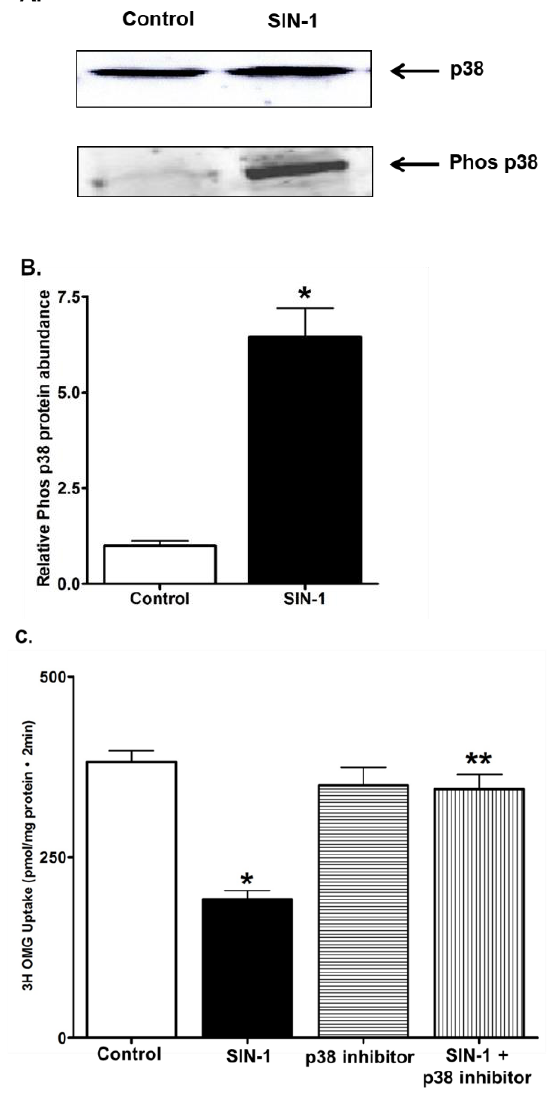
Figure 8. Peroxynitrite activated p38 mitogen-activated protein (MAP) kinase inhibits function of SGLT1. ( A ) Representative Western blot for endogenous p38 and OONO activated phosphorylated p38 expression levels in SIN-1 treated IEC-18 cells. ( B ) Densitometry analysis for phosphorylated p38 levels between control and SIN-1 treatment (n = 4, * p < 0.001). ( C ) Peroxynitrite treatment in the presence